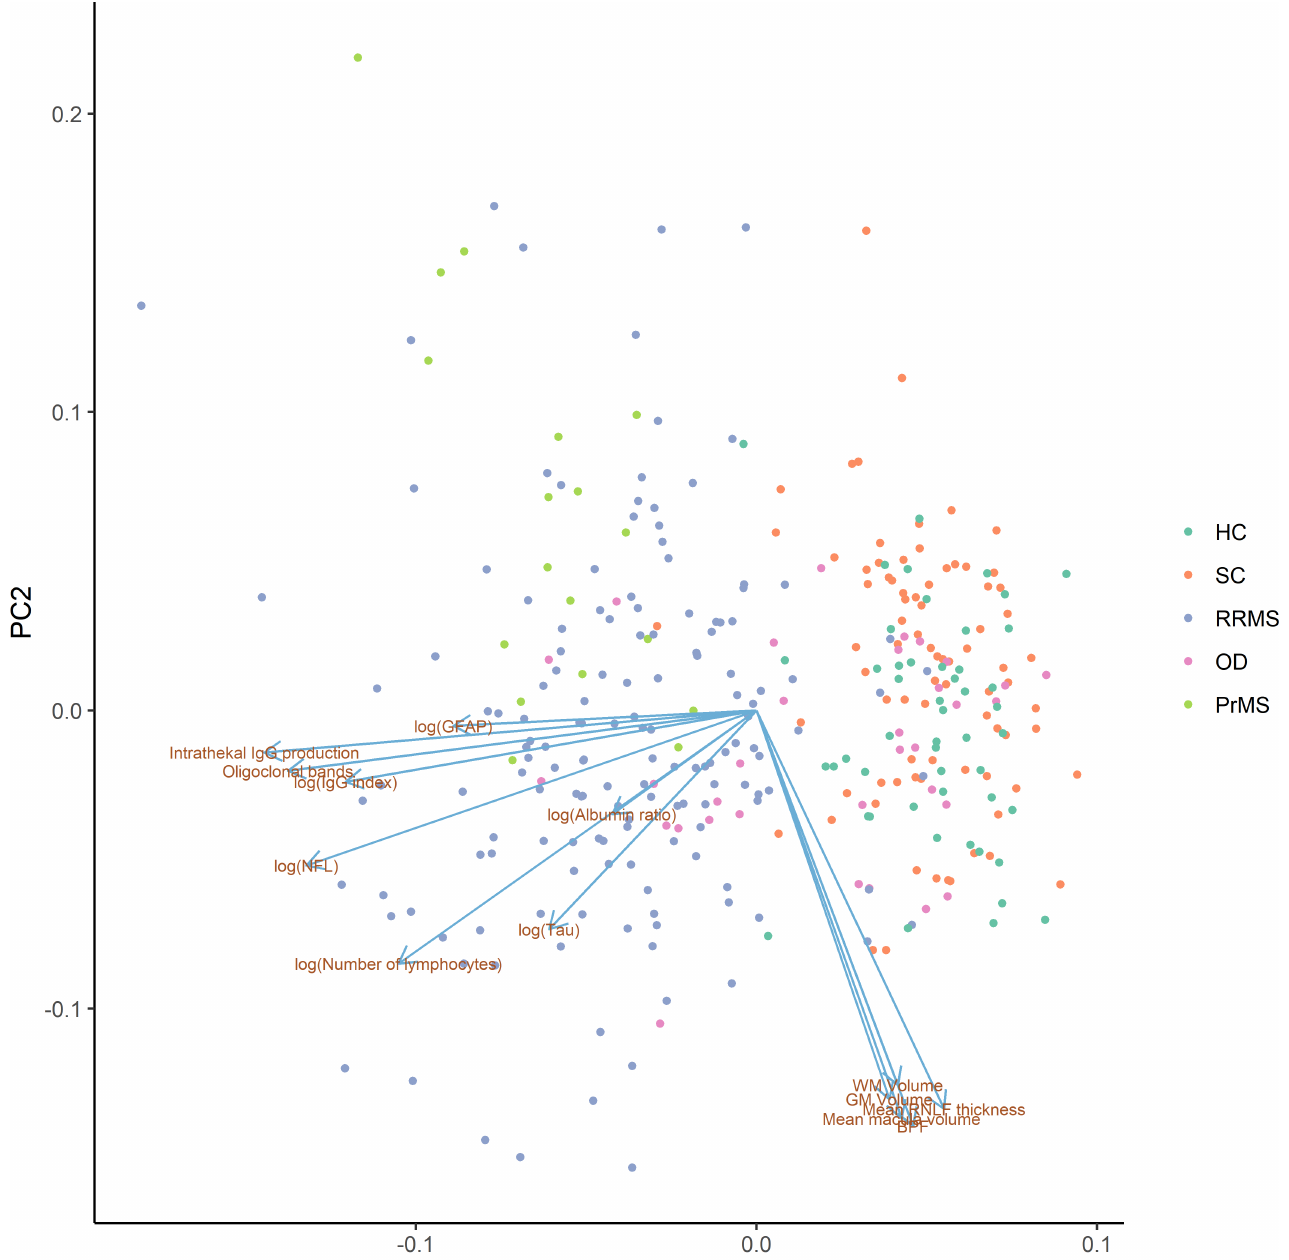
Fig 3. Scatterplot of data projected to the first two principal components (PC1 and PC2). PC1 and PC2 explain 27.7% and 15.7% of the variability in data, respectively (total 43.4%). The projections of the biomarkers onto the principal components are shown as arrows. The HC and SC groups are mainly separated from the RRMS and PrMS groups by the biomarkers measured in the CSF. The OD group overlaps with both of the other groups. https://doi.org/10.1371/journal.pone.0194828.g003 out of 71 RRMS) and the false positive rate increased to 23% (4 SC and 17 OD) (Table 2). On top of intrathecal IgG production and NFL, no additional variables were selected in the final model. Similar error rates were observed with cross-validation as on the training data, indicat- ing a stable fit. The final prediction model can be interpreted as a diagnostic RRMS scale with